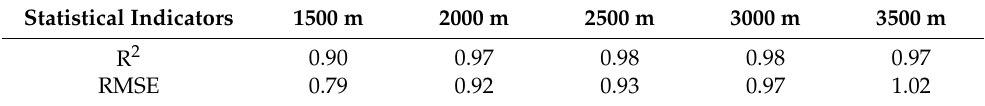
Figure 3. Comparison of LST estimated using the random forest model and nine variables (LAT, NDWI, NDVI, ET, LCT, ALB, Slope, Aspect, and MBE) and original LST at elevations of 1500 m, 2000 m, 2500 m, 3000 m, and 3500 m. Table 2. Accuracy and error of LST estimated using the random forest model at the same elevations. Statistical Indicators